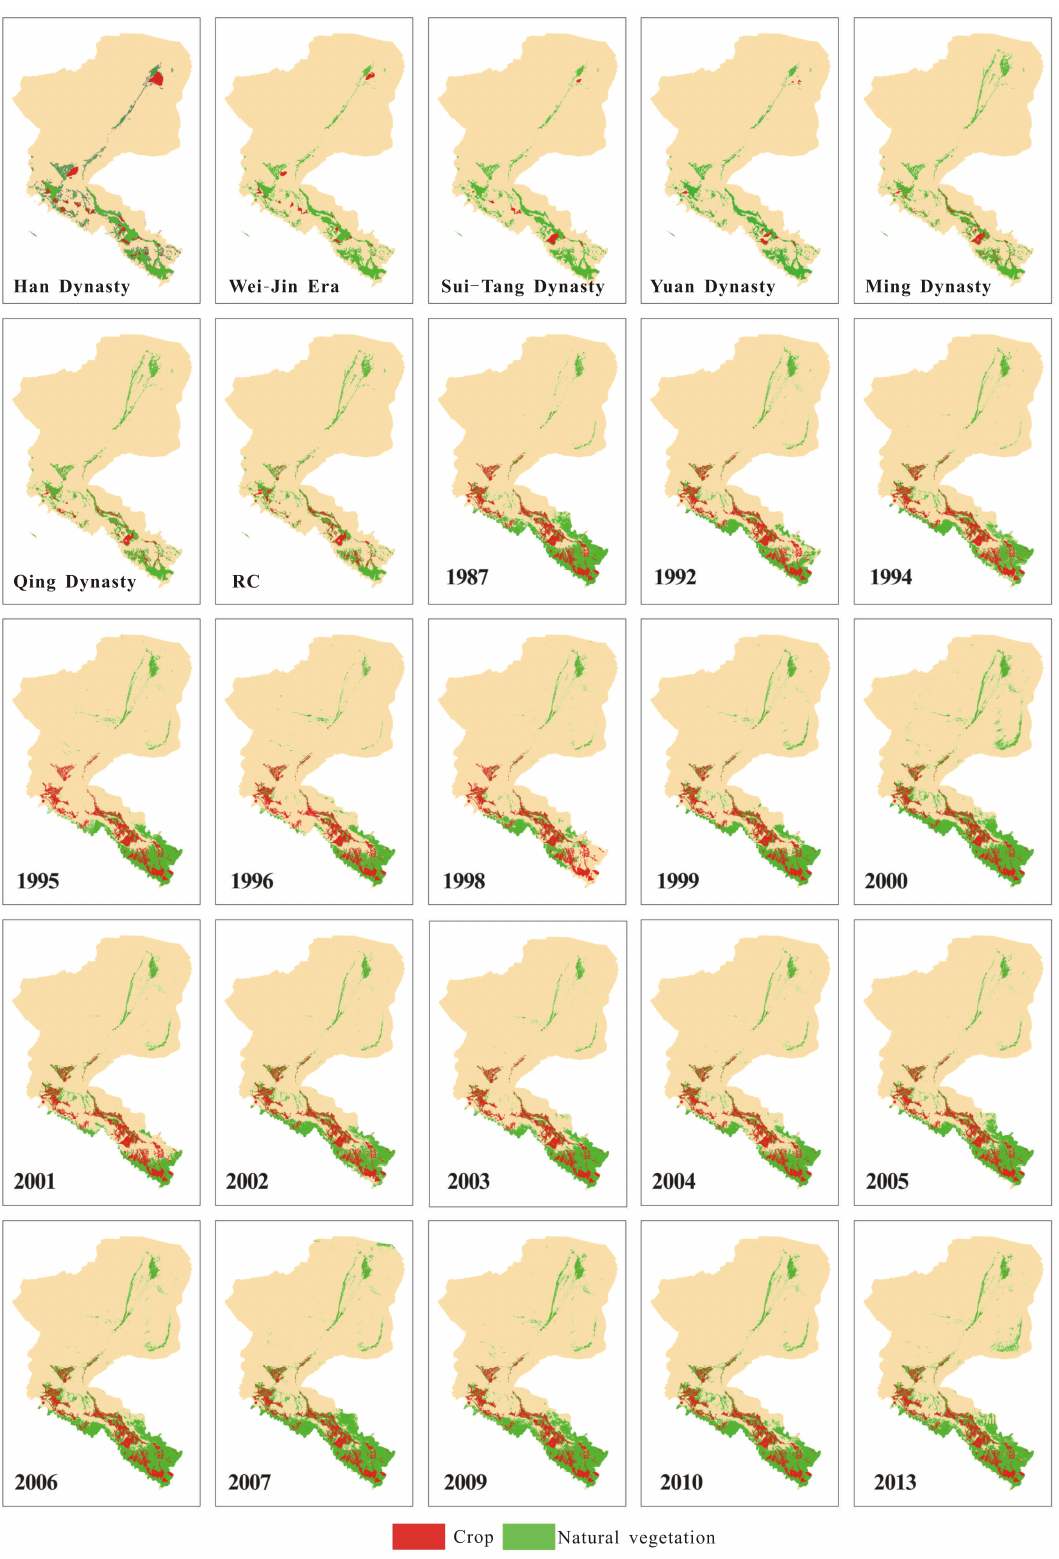
Figure 3. Reconstructed natural (green) and crop (red) vegetation distributions in the past 2000 years. Historic maps (before 1987) were derived from Lu’s results (Lu et al., 2015a) and maps after that were interpreted from Landsat